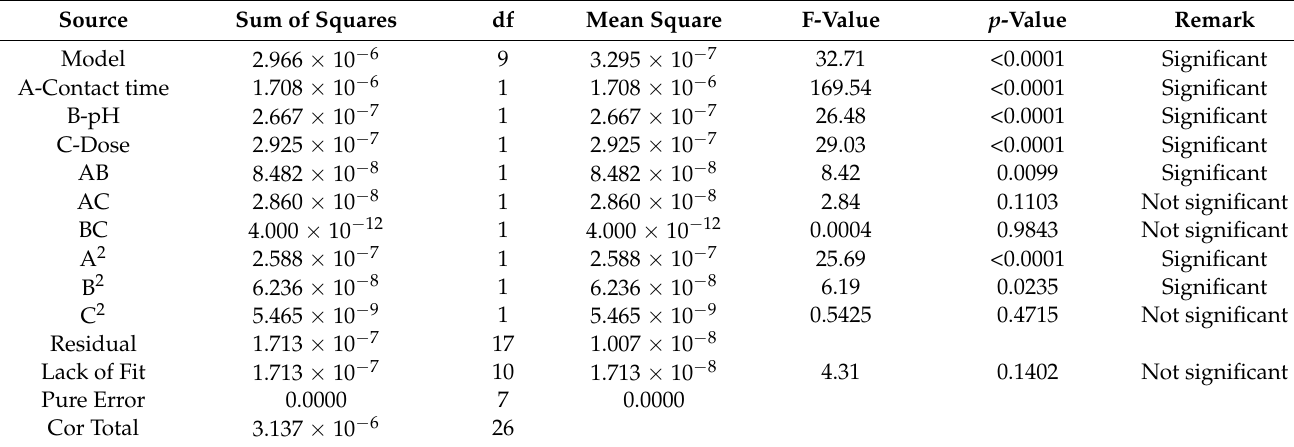
Table 6. ANOVA results of the quadratic model for adsorption of Pb 2+ by Odaracha.